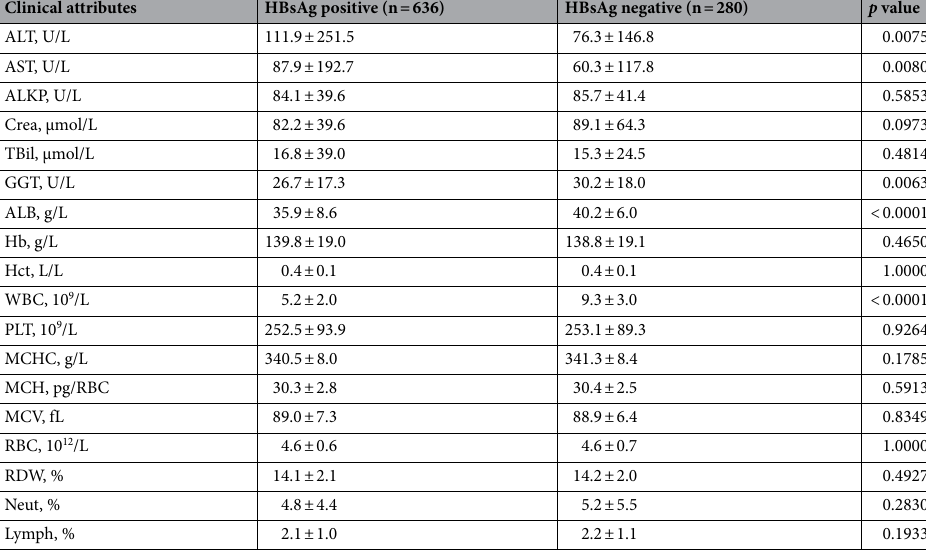
Table 2. Mean serum and blood markers for patients testing positive or negative for hepatitis B surface antigen. Abbreviations for clinical attributes: ALT—alanine aminotransferase; AST—aspartate aminotransferase; ALKP—alkaline phosphate; Crea—creatinine; TBil—total bilirubin; GGT—gamma glutamyl transferase; ALB—albumin; Hb—haemoglobin; Hct—haematocrit; WBC—white blood count; PLT—platelet; MCHC—mean corpuscular haemoglobin concentration; MCH—mean corpuscular haemoglobin; MCV— mean corpuscular volume; RBC—red blood cell; RDW—red cell distribution width; Neut—neutrophils; Lymph—lymphocytes.